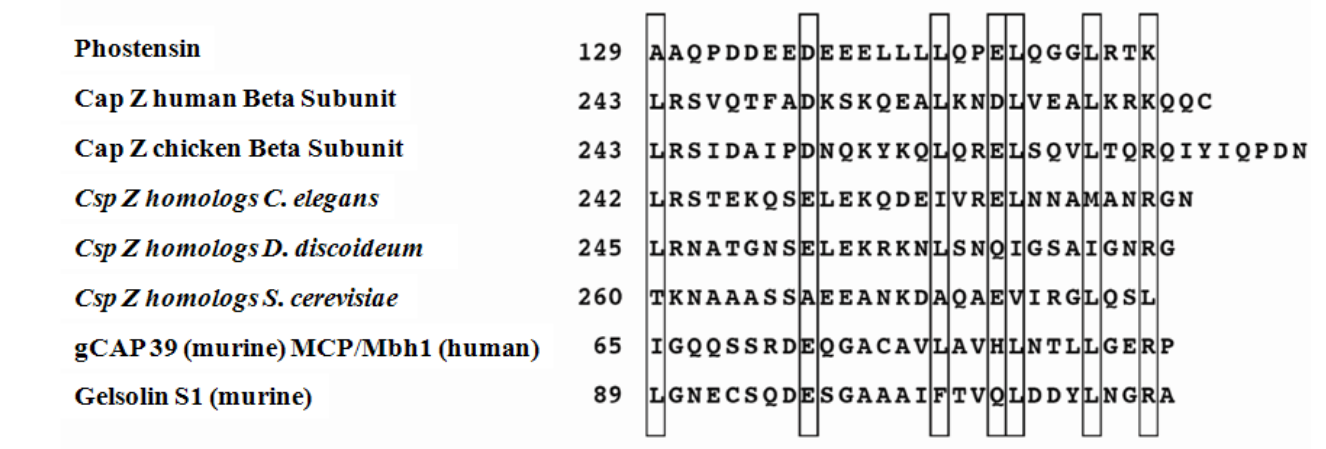
Figure 1. Sequence comparisons between the C -terminal domain of phostensin and other F-actin capping proteins. The consensus sequence for the actin capping motif, L(X) (D/E)(X) L(X) (E/D)L(X) L(X) (K/R), was defined by Barron-Casella et al. 7 6 2 3 2